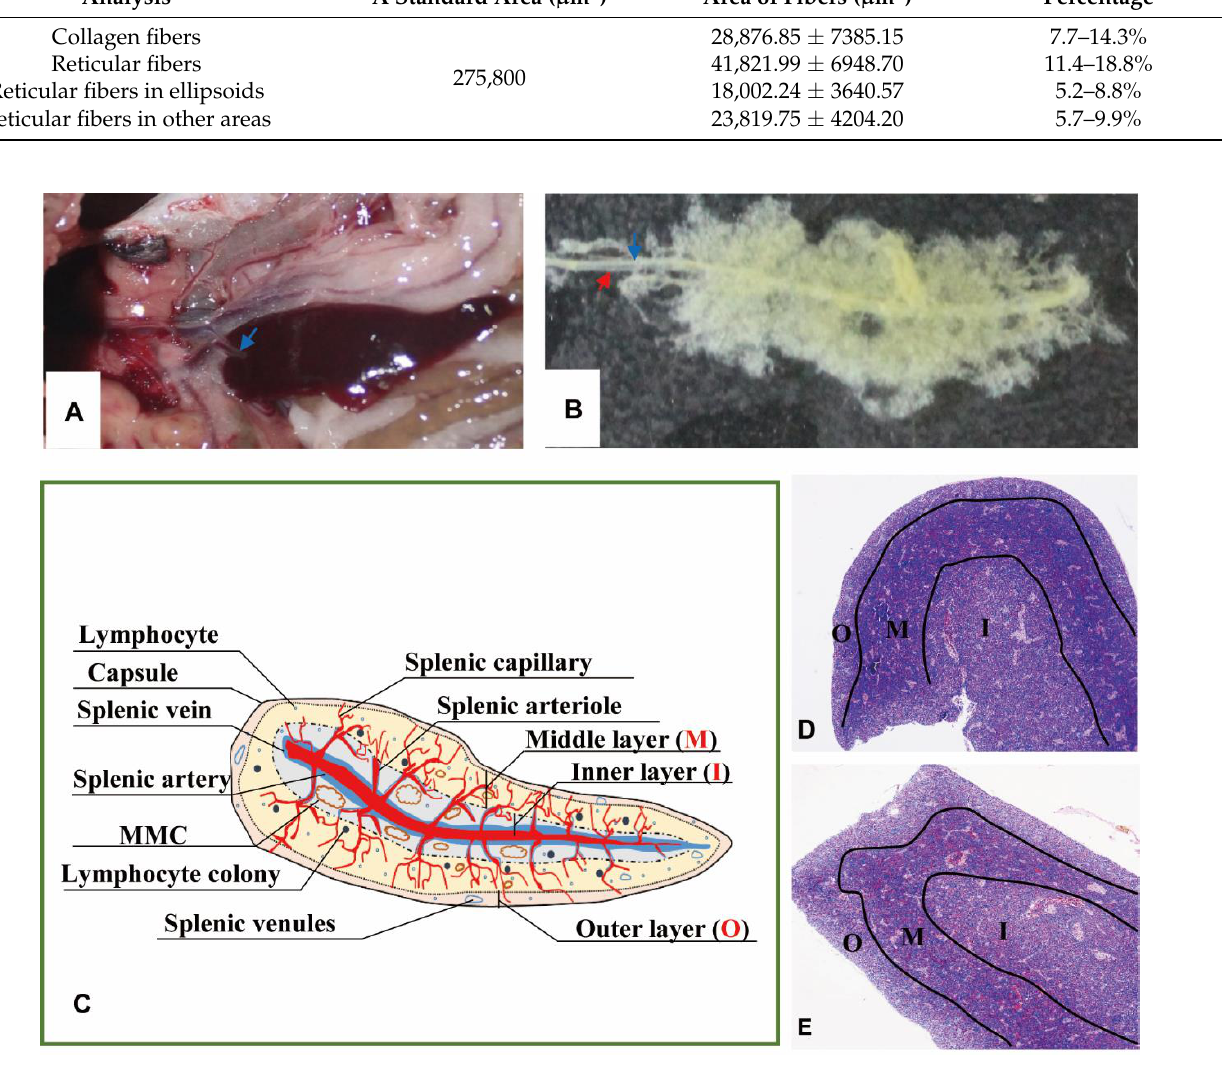
Figure 1. The morphology and portion of the spleen. ( A ). The location of spleen between the gastrointestinal tract, at the head of the spleen sited the splenic portal ( → ). ( B ). Twenty-four days’ post -corruption with 1% NaOH, showing the splenic artery ( → ) and splenic vein ( → ). ( C ). A schematic repre sentation of spleen histological structure. “O”: Outer layer; “M”: Middle layer; “I”: Inner layer; ( D ). Transverse section of the spleen (×40, HE); ( E ). Longitudinal section of the spleen (×40, HE).